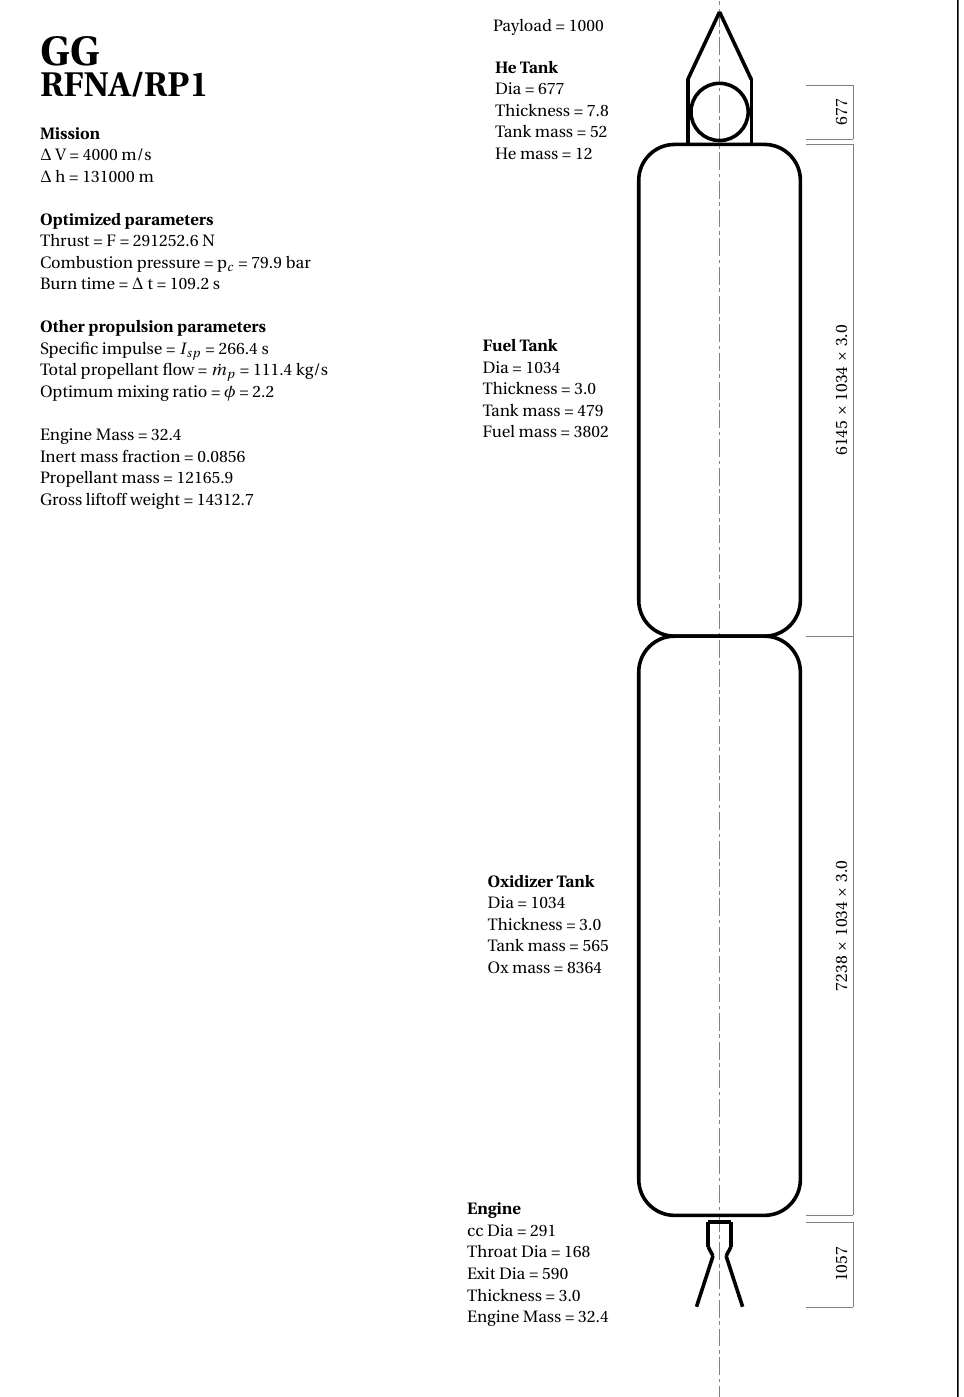
Figure 3. Optimized Engine Parameters, dimensions and masses for